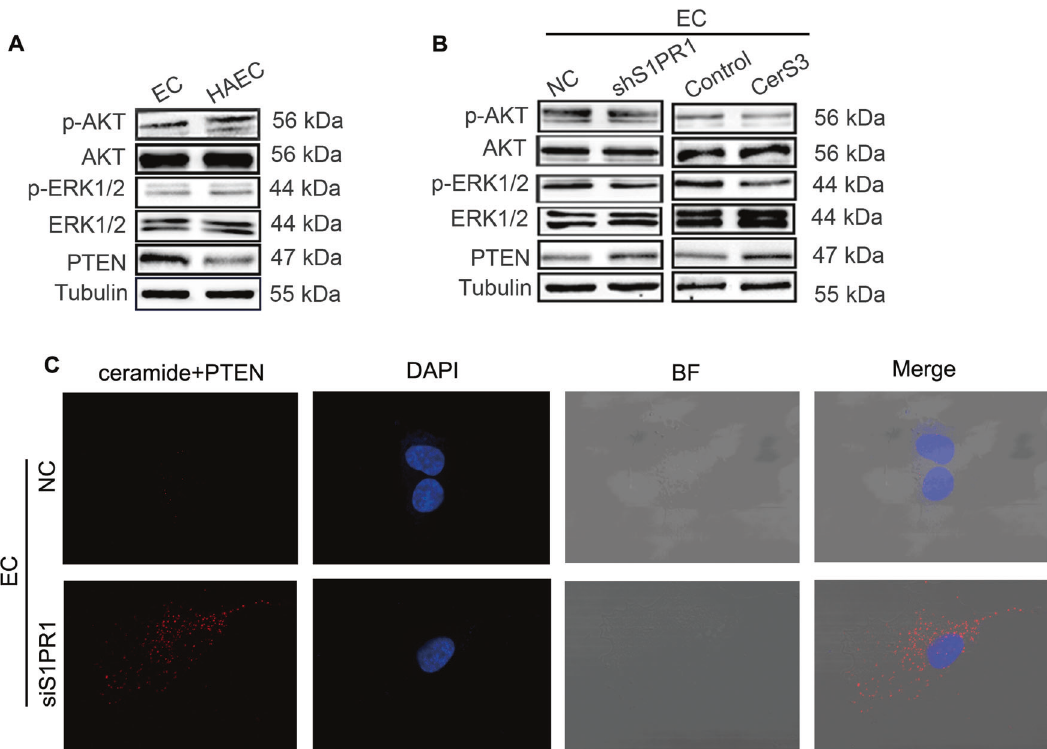
Fig. 6 A reduction in ceramide levels and its interaction with PTEN activates AKT/ERK signalling to promote angiogenesis. A , B p-AKT, AKT, p-ERK, ERK and PTEN expression levels in HAECs ( A ), ECs-shS1PR1 ( B ) and ECs transfected with CerS3 overexpression plasmids ( B ) were determined by WB. C An interaction between endogenous ceramide and PTEN was detected by PLA in ECs with S1PR1 knockdown. BF bright fi